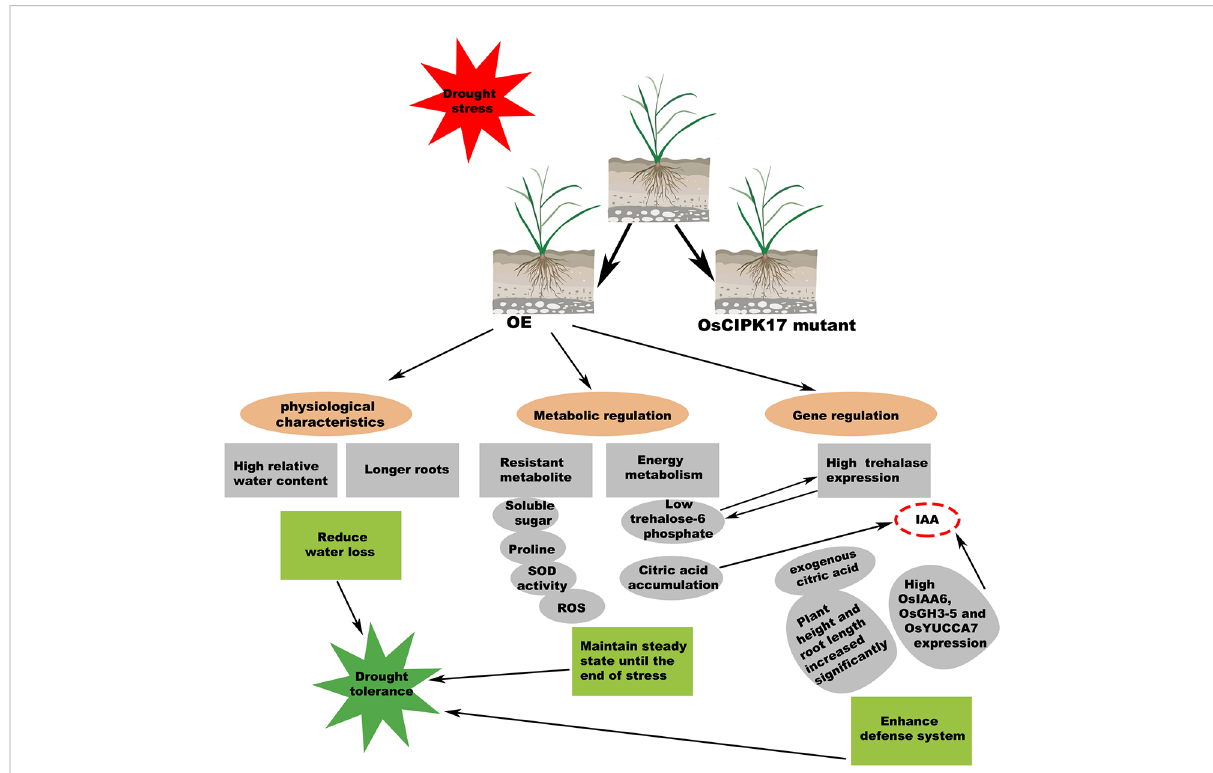
FIGURE 10 Summary of major metabolic events observed, which confer drought tolerance through OsCIPK17 -OE in rice. The features described in this work are marked with gray ellipses. Possible connections are connected by dashed